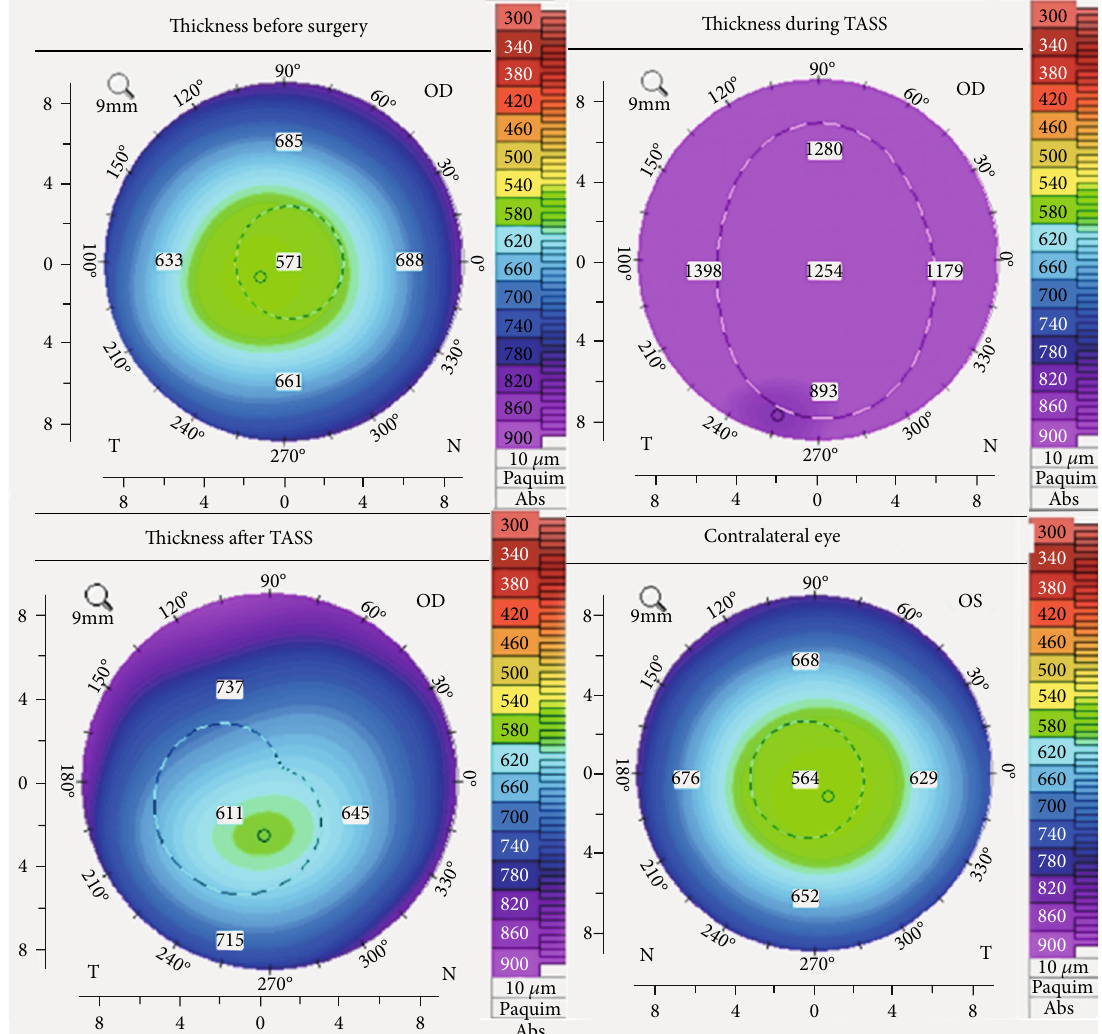
Figure 7: Corneal thickness before surgery, during and after TASS of the right eye. Thickness of contralateral